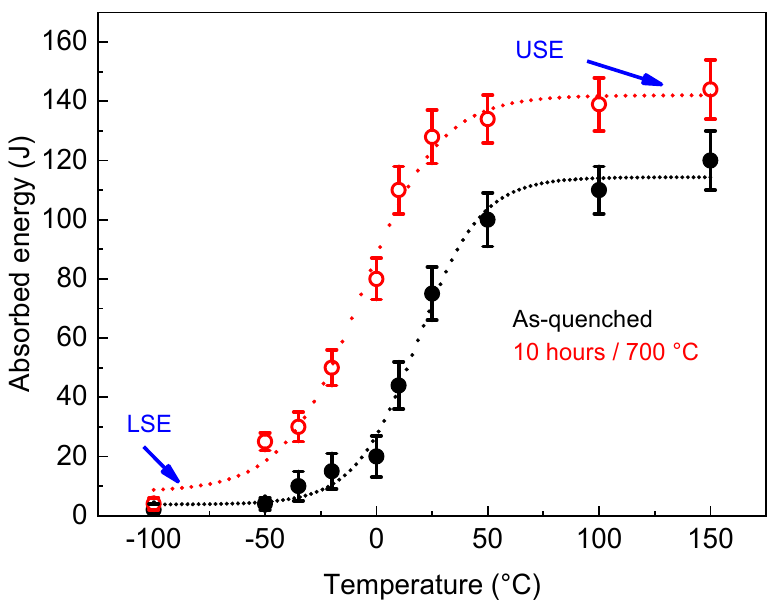
Figure 2. Absorbed energy vs. test temperature of Cr martensitic steel in as-quenched condition and after heat treatment for 10 h at 700 °C. Table 2. Ductile to brittle transition temperature (DBTT) and USE values determined from the curves in Figure 2.